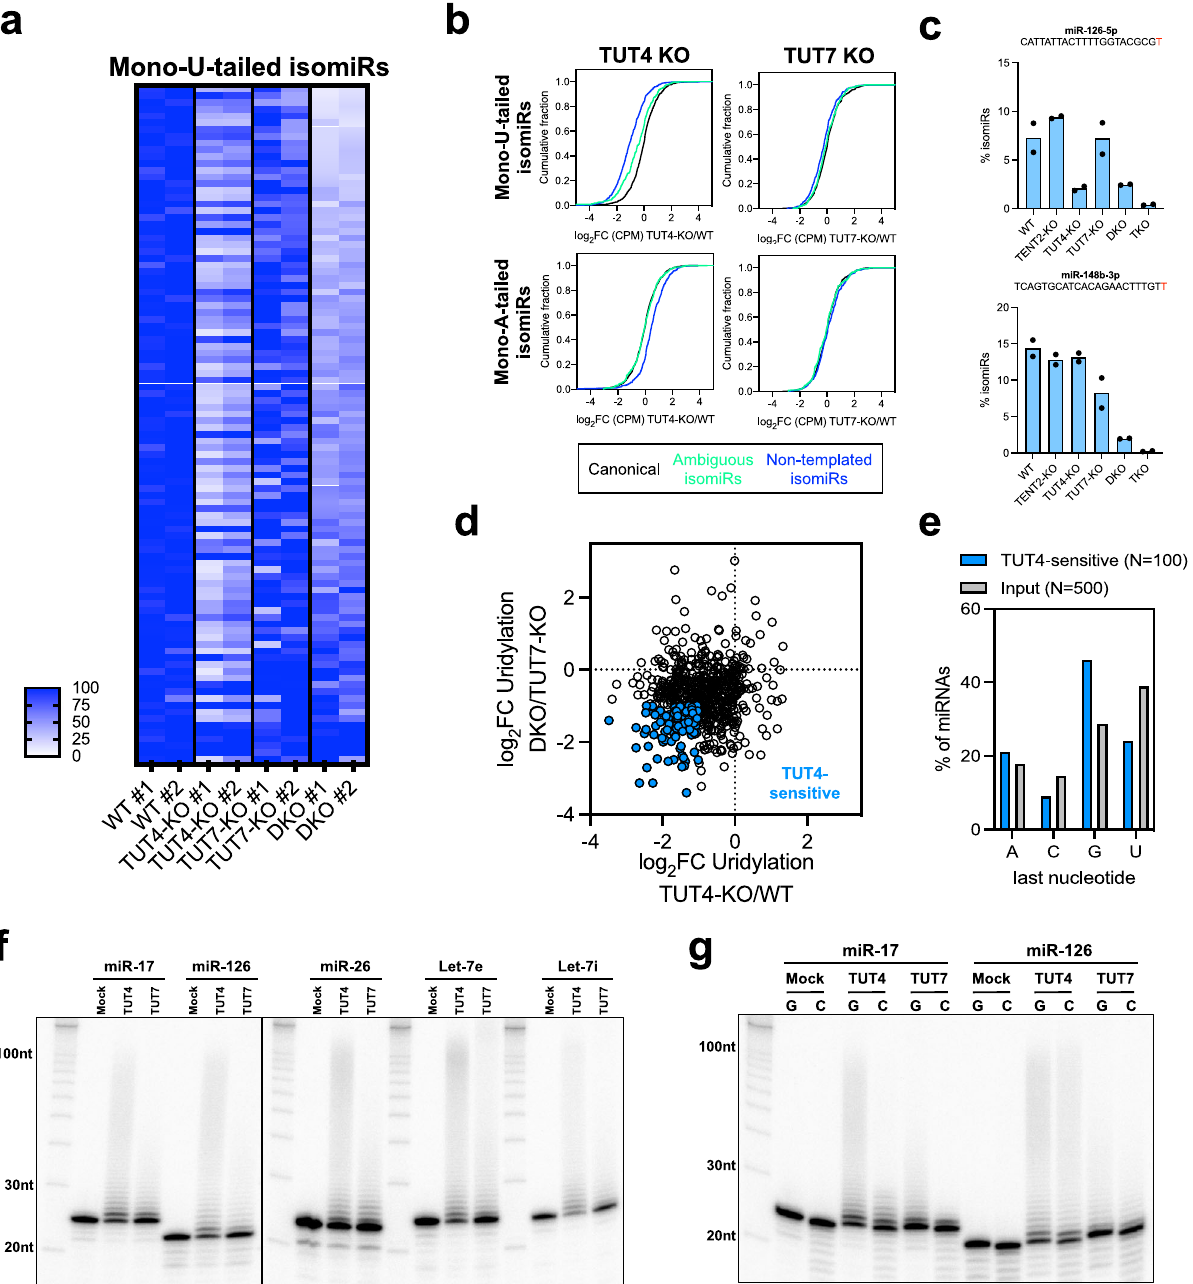
Fig. 5 | TUT4 but not TUT7 selectively uridylates most mature miRNAs. a Heatmapoftherelativeabundanceofmono-uridylatedisomiRsbetweenWTand knockout cells. Colorimetric scale ranges in values between 0 and ≥ 100 (more details in Supplementary Fig. 5c). b Cumulative curves of all mono-uridylated (upperpanel)andmono-adenylated(lowerpanel)isomiRsuponknockoutofTUT4 or TUT7. Colored lines indicate canonicalmiRNAs (black),ambiguous (green),and NT (blue) isomiRs. c Percentage of uridylated isomiRs across single, double, and triple knockout of TENT2, TUT4, and TUT7. Sequences indicate templated nucleotides(black)andNTadenylation(red).Dotsrepresentthevaluesobtainedin